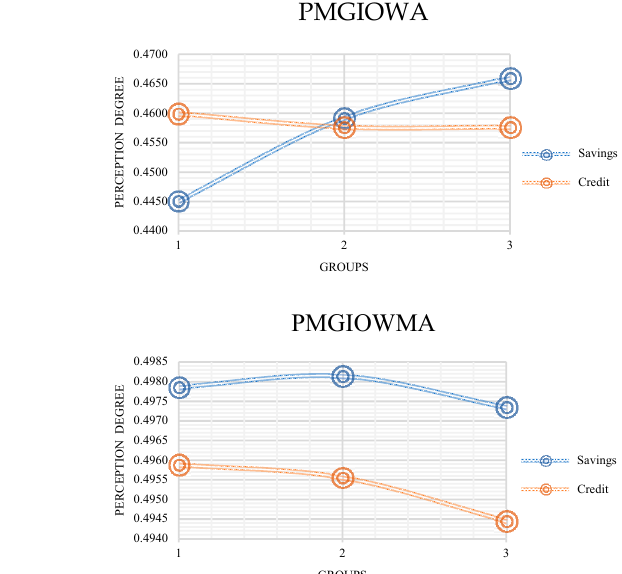
Figure 2. Perceptions of savings and credit by each method.